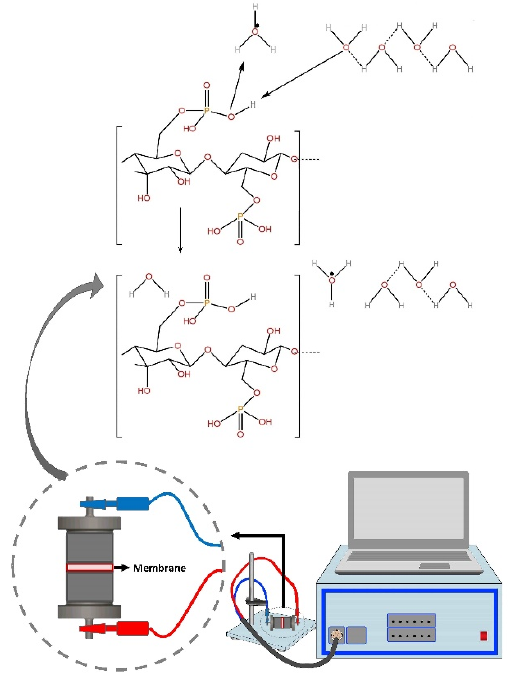
Figure 4. Schematic of ion transport mechanism of the phosphorylated NdC membrane.